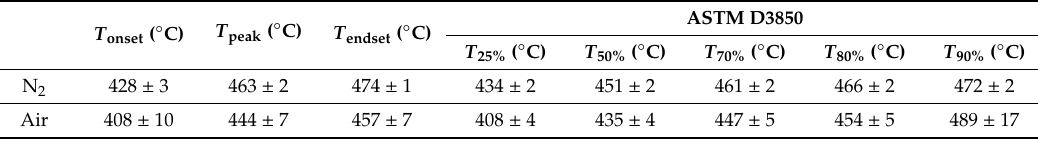
Table 1. Thermal stability of [C 9 C 1 im][NTf 2 ] in terms of decomposition temperatures. T onset (°C) T peak (°C) T endset (°C)